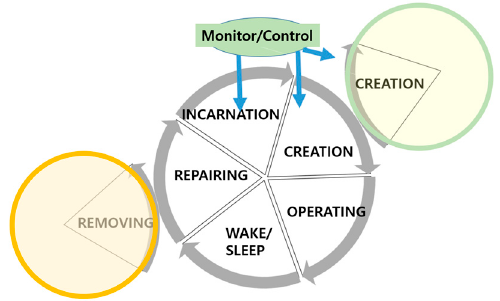
Figure 9. Memory Storage Management Cycle.